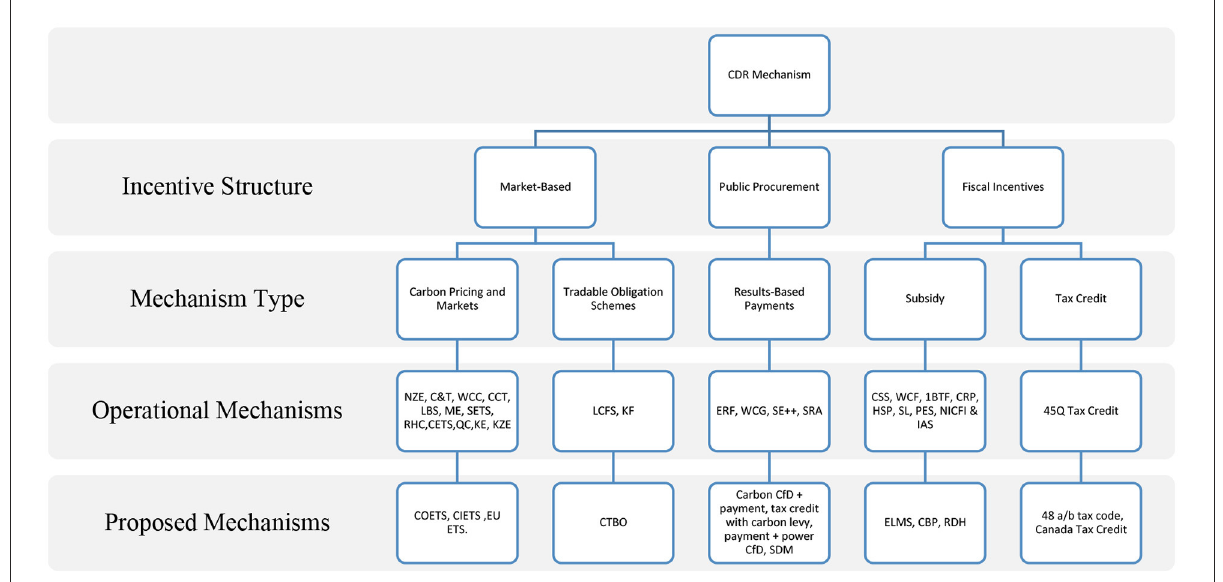
FIGURE1 Categorisation of mechanisms. Carbon pricing and markets: WCC, Woodland Carbon Code; C&T, California Cap and Trade; NZE, New Zealand ETS; LBC, Label Bas Carbone; RHC, Registro de Huella de Carbono; CCT, Colombia’s Carbon Tax; CETS, China ETS; QC, Québec Cap-and-Trade System; KE, Korean ETS; KZE, Kazakhstan ETS; SETS, Saitama’s ETS; COETS, Colombia ETS. Tradeable obligation scheme: LCFS, Low-Carbon Fuel Standard; KF, Klik foundation; CTBO, Carbon Take Back Obligation. Results-based payments: WCG, Woodland Carbon Guarantee; ERF, Emissions Reductions Fund; CfD, Contract for Difference; SRA, Swedish Reverse Auction. Subsidy: CSS, Countryside Stewardship Scheme; WCF, Woodland Carbon Fund; 1BTF, One Billion Trees Fund; CRP, Conservation Reserve Program; HSP, CDFA Healthy Soils Program; SL, Sowing Life; IAS, Ireland’s Afforestation Scheme; PES, Costa Rica’s; NICFI, Norway’s; ELMS, Environment Land Management Scheme; RDH, Regional Direct Air Capture Hubs. Tax credit: 45Q, 48a/b tax code, Canada Tax